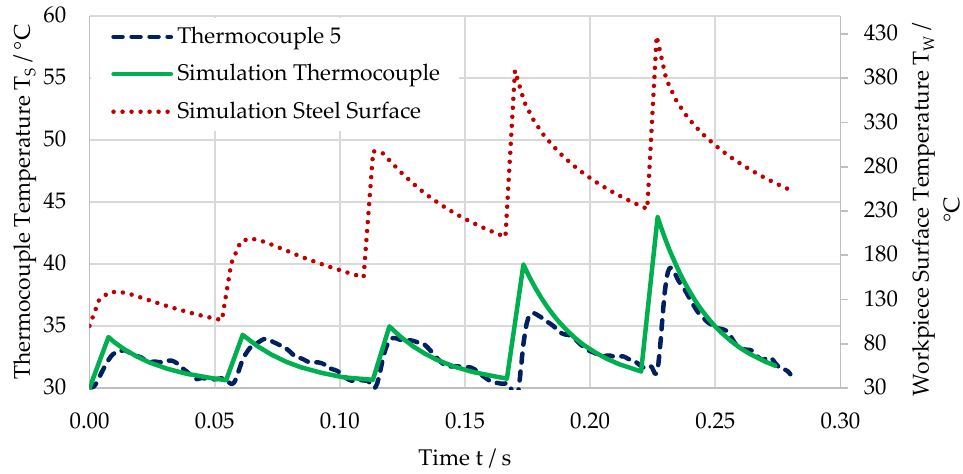
Figure 11. Temperature for the last five cuts before the destruction of the thermocouple for a feed of f = 36 µm. Measured temperature (dashed blue line), simulated temperature at workpiece surface (dotted red line), and calculated temperature of thermocouple (solid green line).